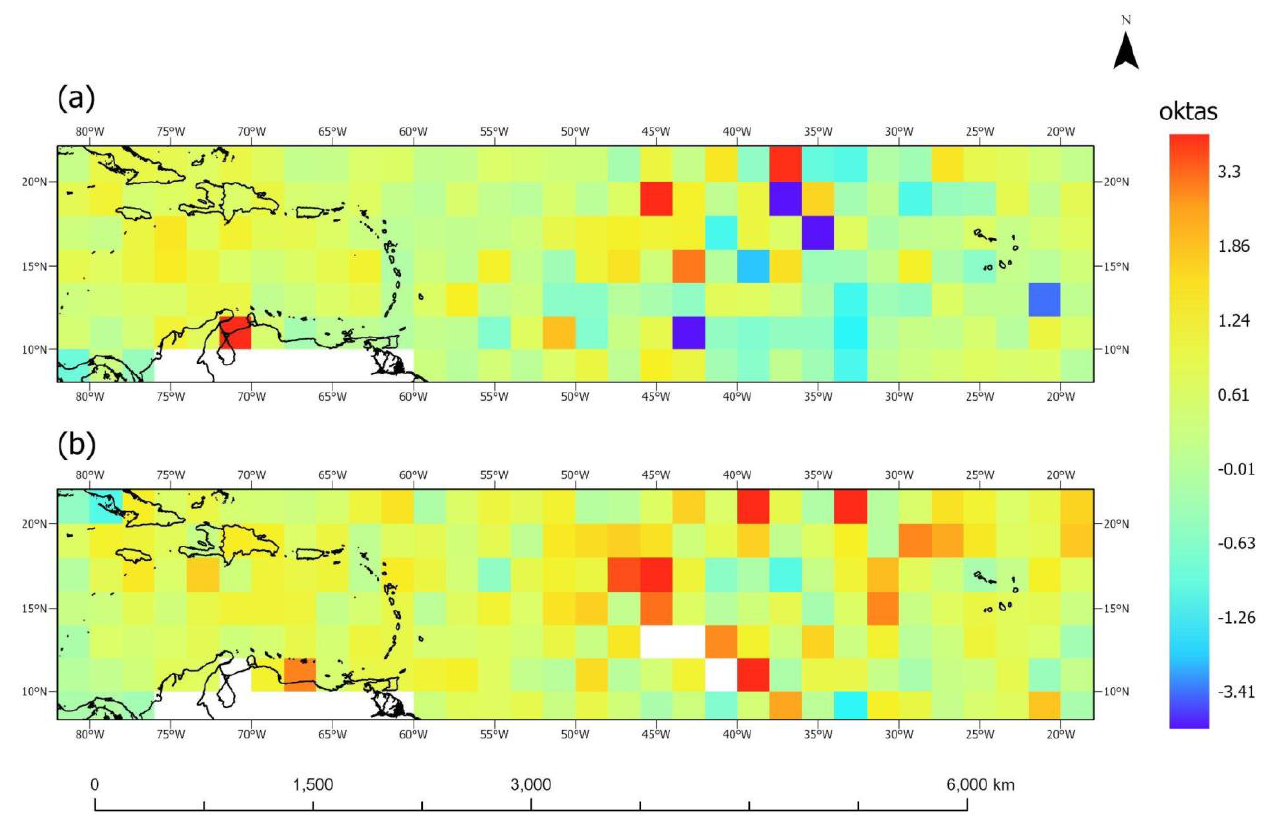
Figure 5. Cloud cover (CC) composite anomalies in the MDR of the NA basin for the 2005 ( a ) and 2020 ( b ) hurricane seasons